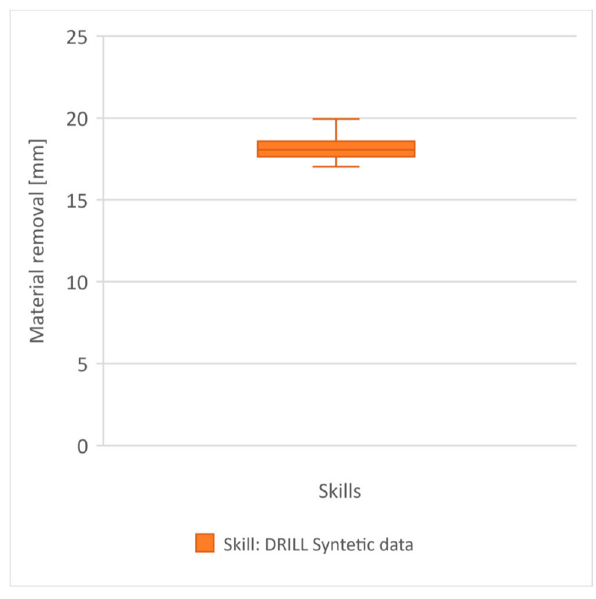
Figure 13. Material removal-based datasets used as synthetic data for the implementation case.